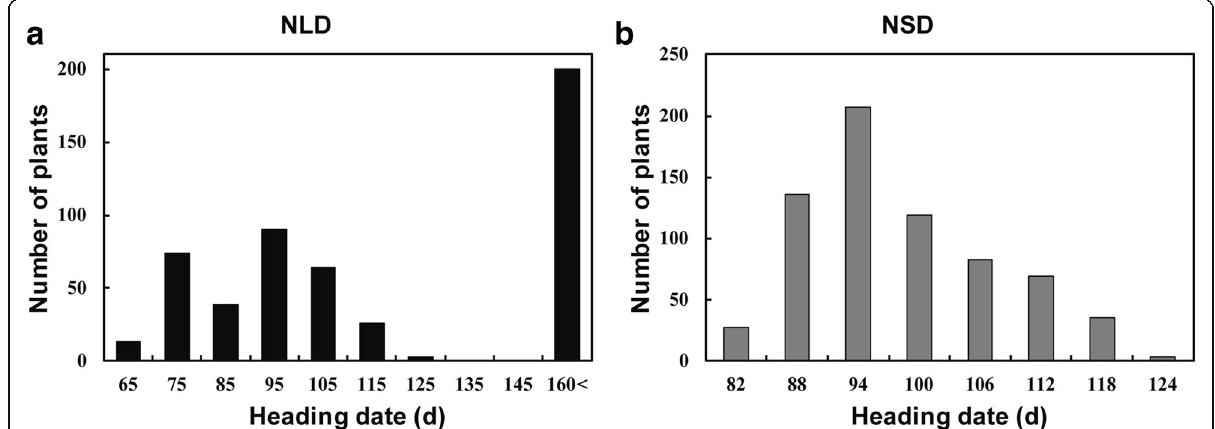
Fig. 1 The heading date distribution of 4-gene segregating populations under NLD and NSD conditions. The heading date distribution of NIL-F 2 population under NLD conditions ( a ) and of NIL-F 3 population under NSD conditions ( b ). “ 160< ” , non-heading after 160 days from